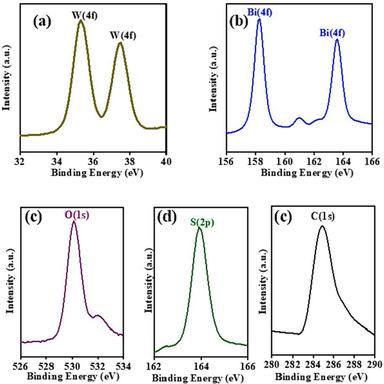
High-resolution X-ray Photoelectron Spectroscopy (XPS) data for W, B, O, S, and C.